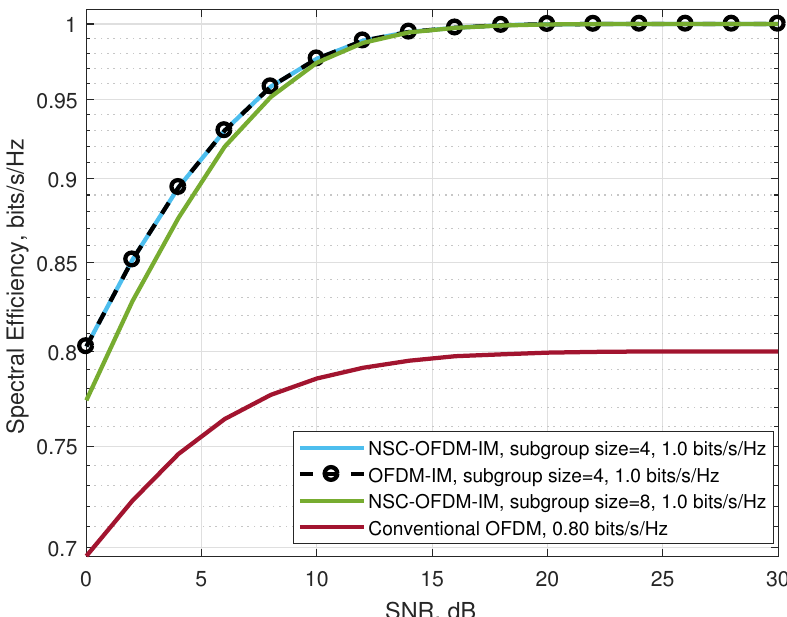
Figure 9. Comparison of the proposed NSC-OFDM-IM with conventional OFDM/OFDM-IM in terms of spectral efficiency, where the BPSK modulation was adopted.